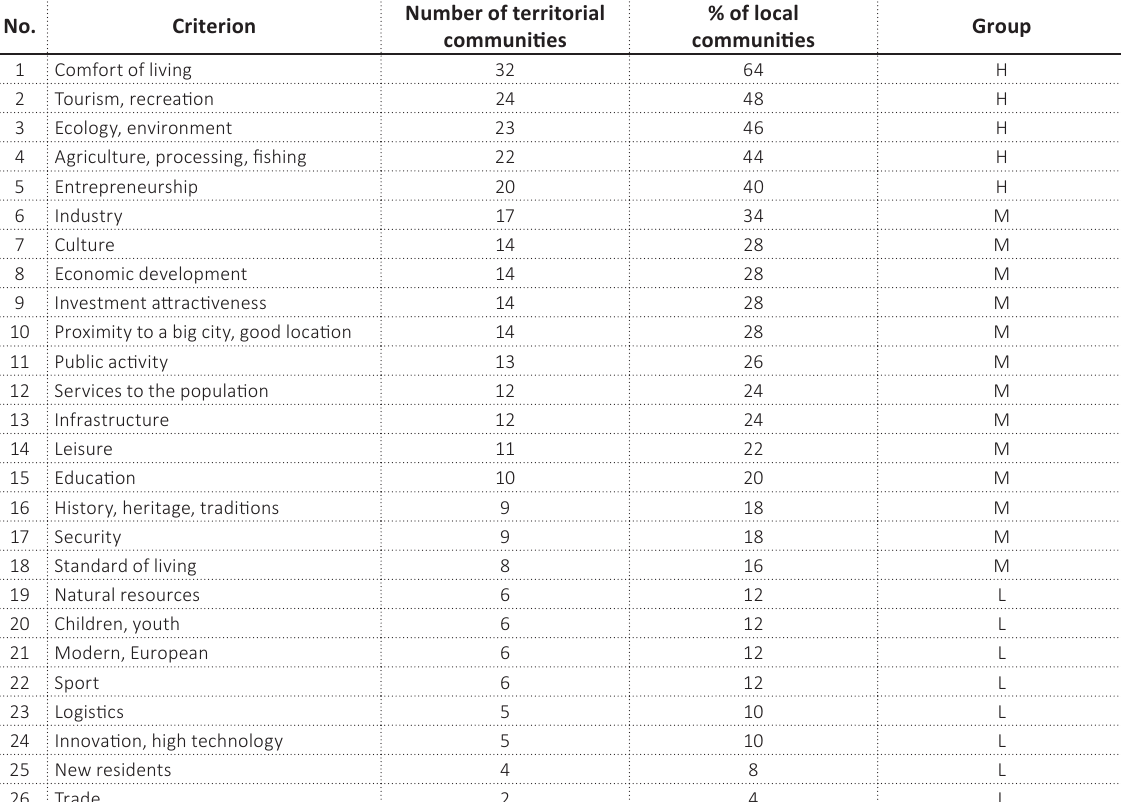
Table 2. Application frequency of positioning criteria